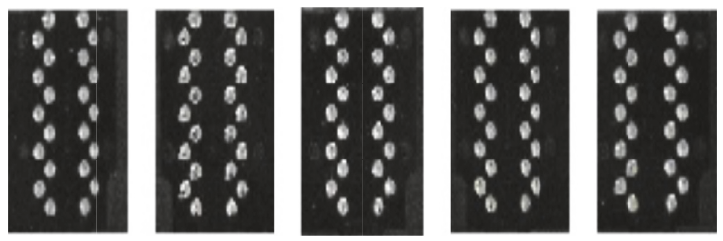
Figure 7: Some solder joint samples.